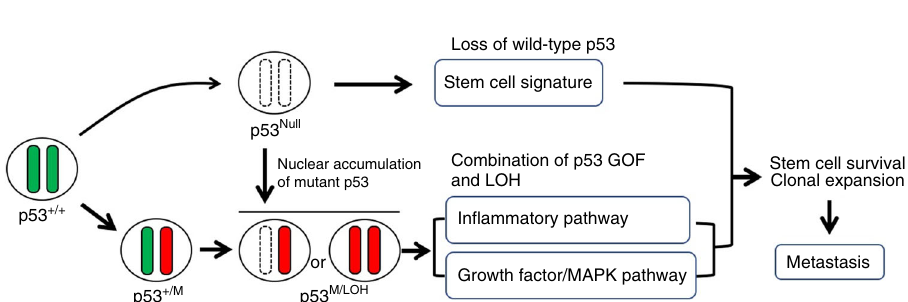
Fig. 8 A schematic illustration of the for TP53 / Trp53 mutation and metastasis. Loss of wild-type p53 increases stemness, while combination of p53 GOF mutation with LOH activates in fl ammatory and MAPK pathway. Corporation of these pathways may cause acquisition of single-cell survival and clonal expansion abilities, which promotes